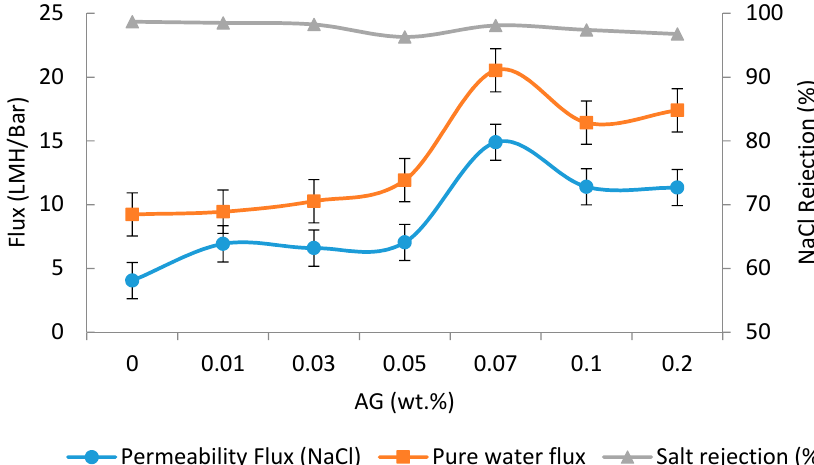
Figure 7. Fluxes and salt rejection of PA/AG-containing membranes at different AG (wt.%) loadings in dope solutions. Feed solution: 2000 ppm NaCl, pH 7. Operating pressure: 15 bars.